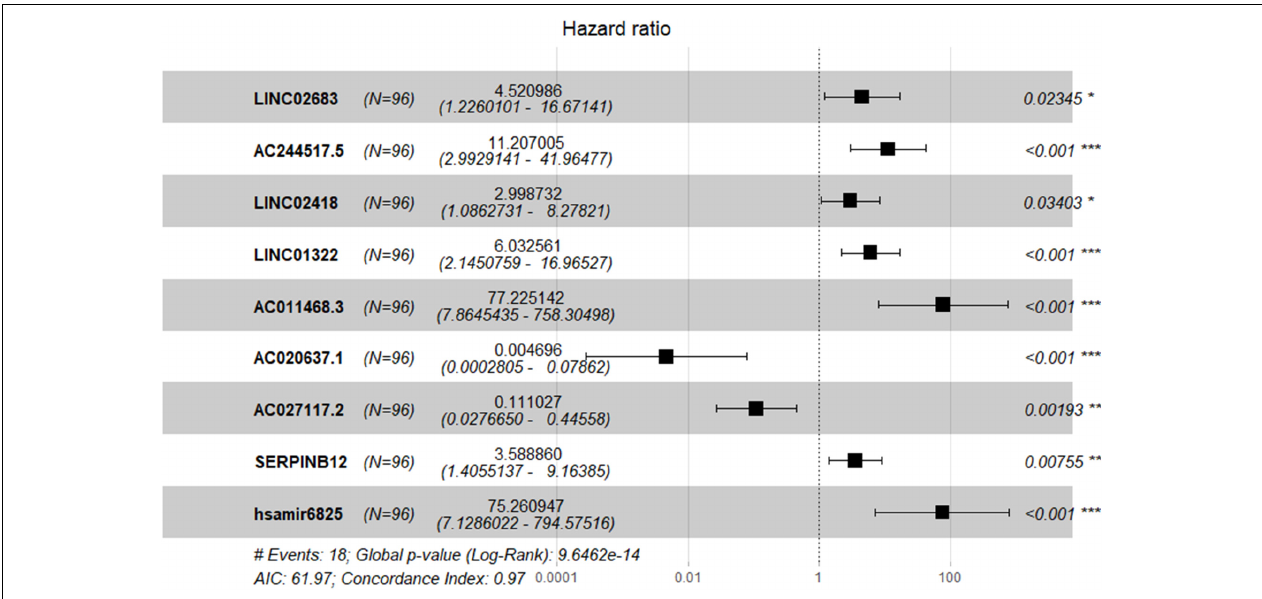
FIGURE 2 | Expression profiles of nine genes for prediction of RFS in stage I-IIIA LUSC by multivariate Cox regression.